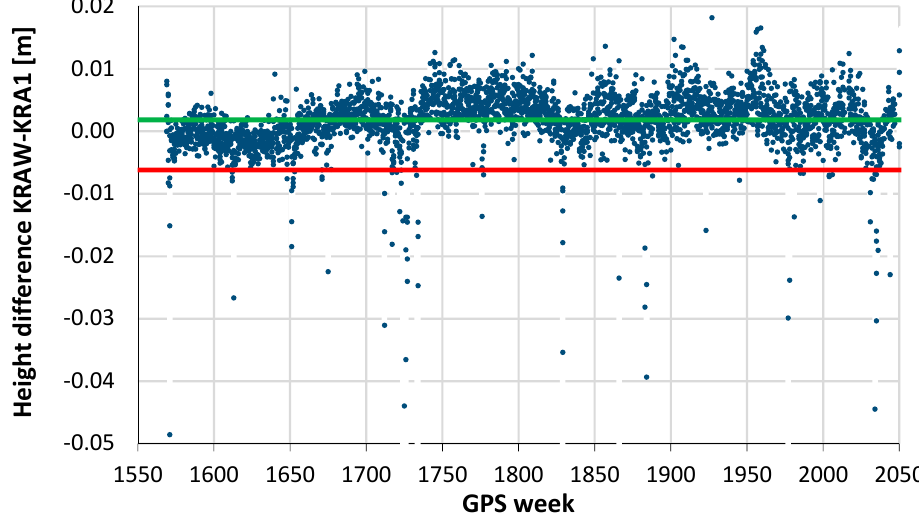
Figure 8. Height difference between KRA1–KRAW from NGL–PPP (navy dots), systematic difference from levelling − 6.2 mm (red line), and mean difference 1.83 mm (green line) [31].